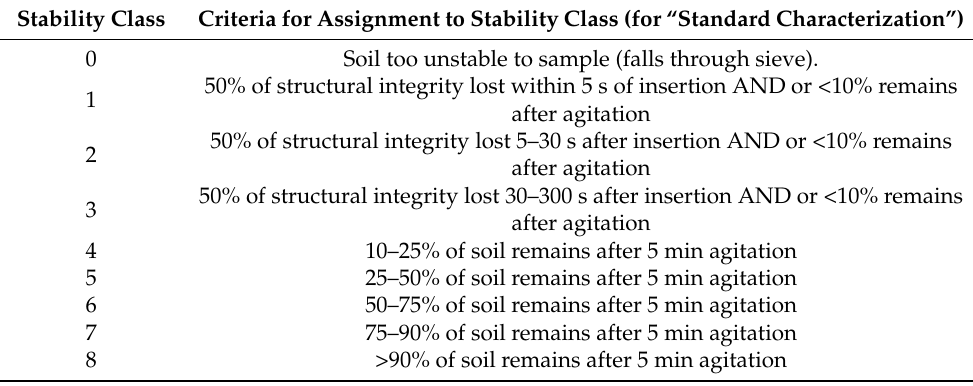
Table 2. Criteria for scoring soil stability in water adapted from Herrick et al. [50]. Stability